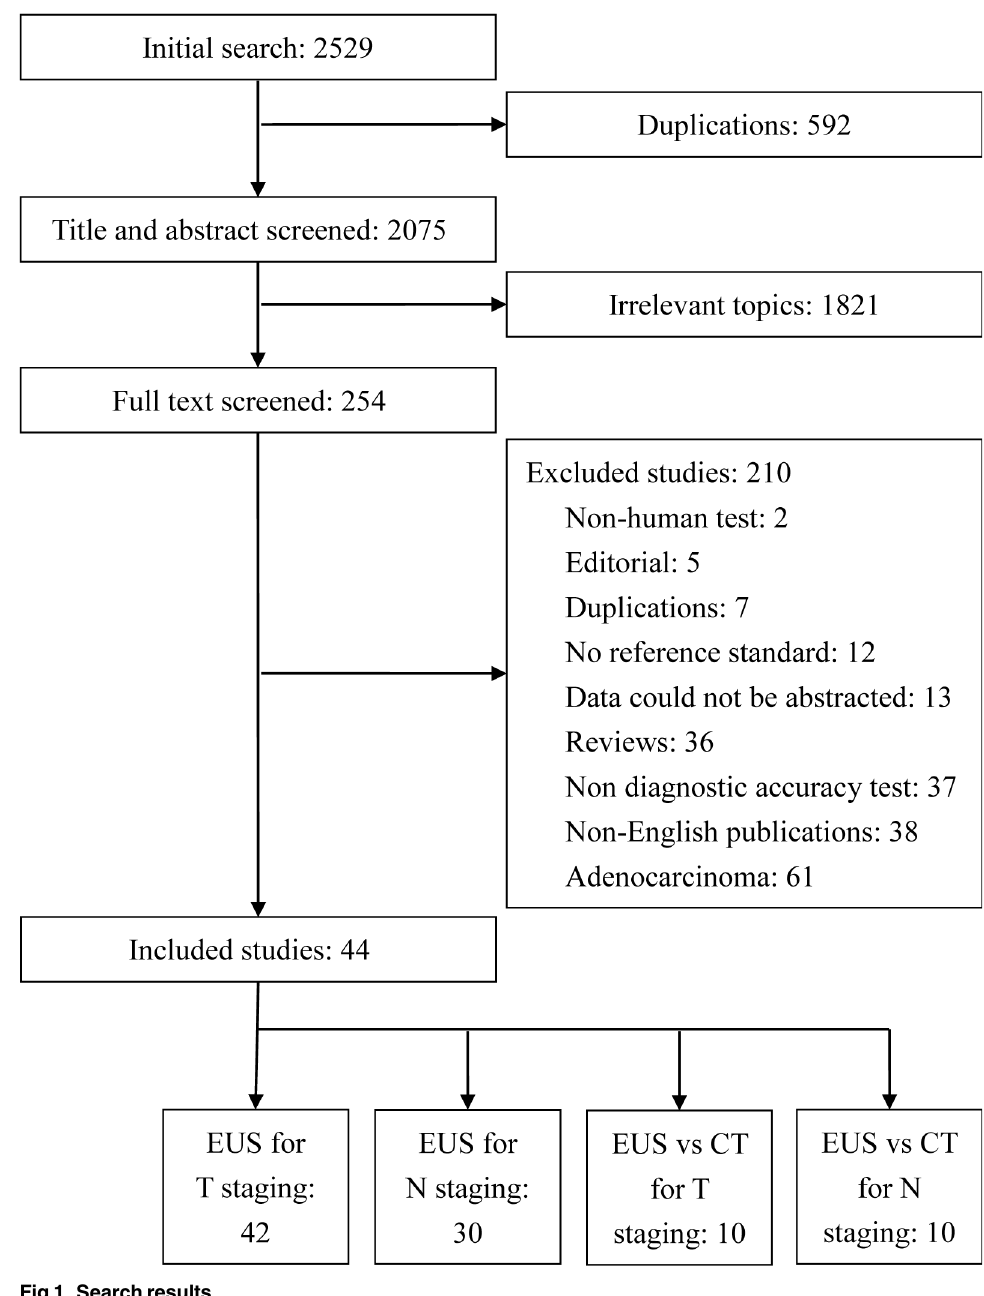
Fig 1. Search results.